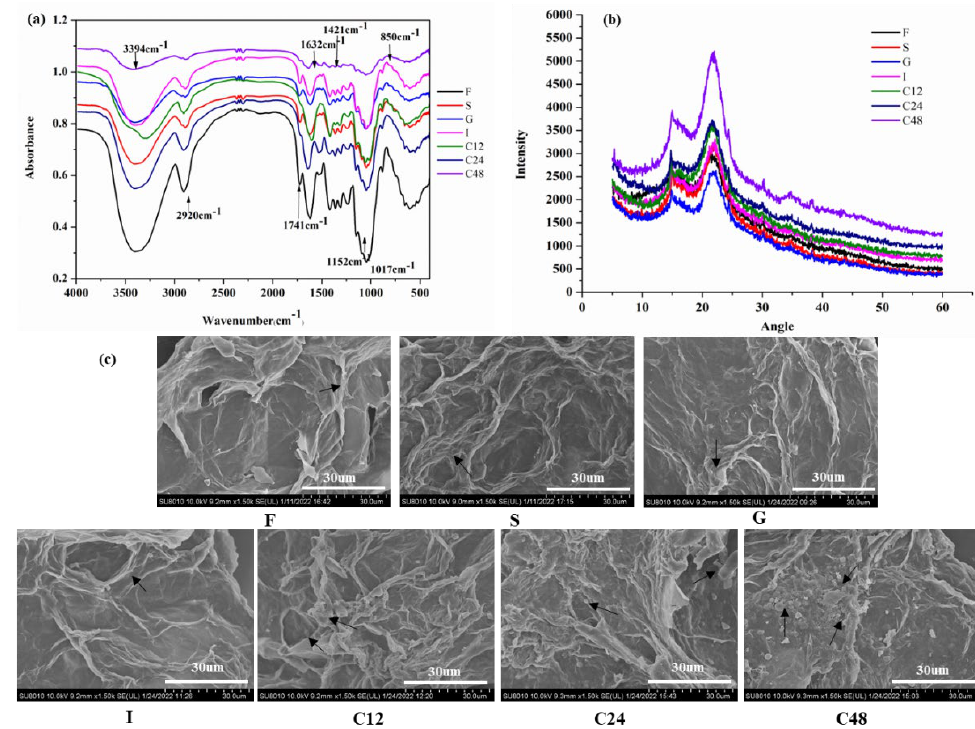
Figure 6. Characterization of total dietary fiber from sweet potato residues fermented with com- images ( c ) of total dietary fiber from sweet potato residues fermented with combined strains during bined strains during in vitro digestion and colonic fermentation. ( a – c ) F, TDF of FSPR; S, TDF of in vitro digestion and colonic fermentation. F: TDF of FSPR; S: TDF of FSPR after simulated salivary FSPR after simulated salivary digestion; G, TDF of FSPR after simulated gastric digestion; I, TDF of di-gestion; G: TDF of FSPR after simulated gastric digestion; I: TDF of FSPR after simulated intestinal FSPR after simulated intestinal digestion; C12, C24, and C48, TDF of FSPR after simulated colonic digestion; C12, C24, and C48: TDF of FSPR after simulated colonic fermentation for 12, 24, and 48 h; fermentation for 12, 24, and 48 h. Arrows: the representative morphological structure of TDF in the